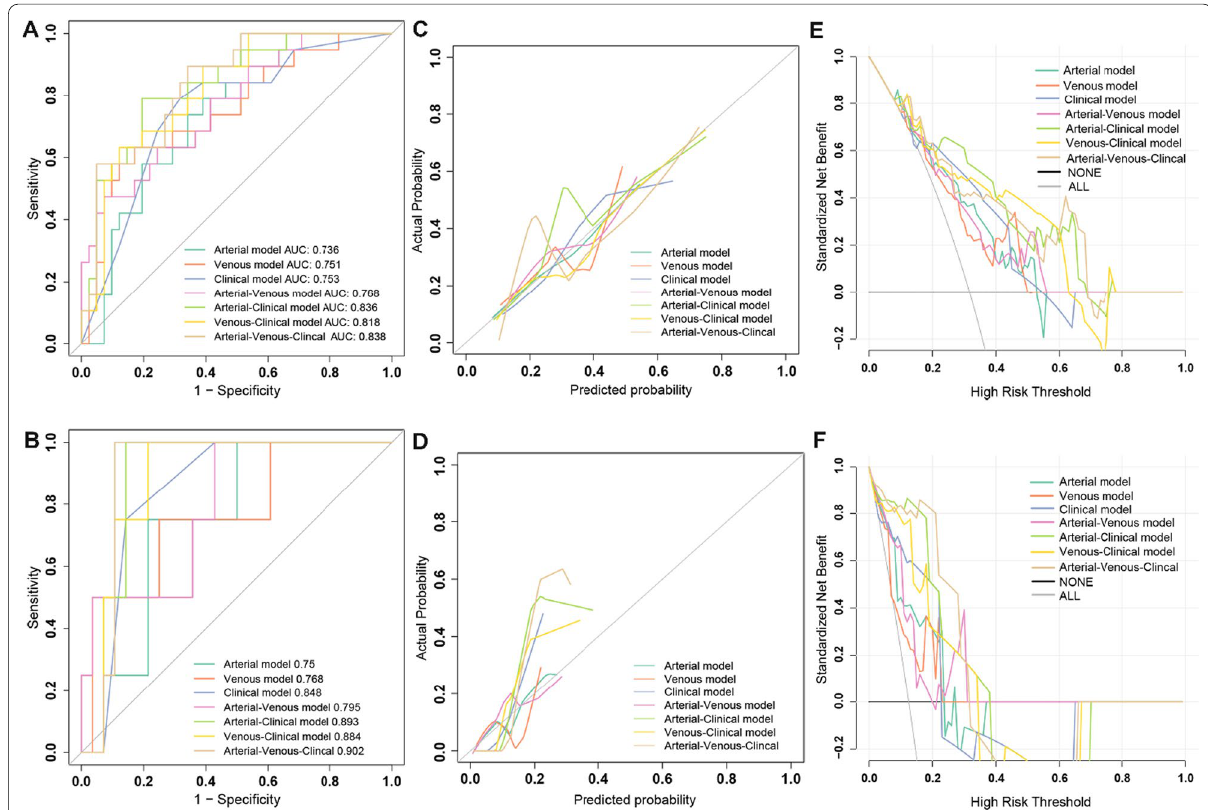
Fig. 3 The performance of different models. A , B ROC curves of different models for predicting pathological complete response (pCR) of adenocarcinoma of the esophagogastric junction (AEG) in the training group ( A ) and external validation group ( B ). C , D Calibration curves of different models predicting pCR in the training group ( C ) and external validation group ( D ). The 45-degree sloping line indicates the ideal calibration, and the closer the model calibration curve is to the ideal calibration line, the better the agreement between the model predicted probability and the actual probability. E , F Decision curves of different prediction models in the training group ( E ) and external validation group ( F ). The X-axis is the threshold probability range, and the Y-axis is the net benefit. The black line labeled "NONE" indicates that no lesions are assumed to be pCR, and the gray line labeled "ALL" indicates that all lesions are assumed to be pCR. The further away from both the black and gray lines, the higher the net benefit of the model compared to performance utilizing the "NONE" and "ALL" assumptions. When comparing the decision curves of different models within the same range of threshold probability, the larger the area under the curve for the same threshold probability interval, the higher the net benefit of the model at that threshold